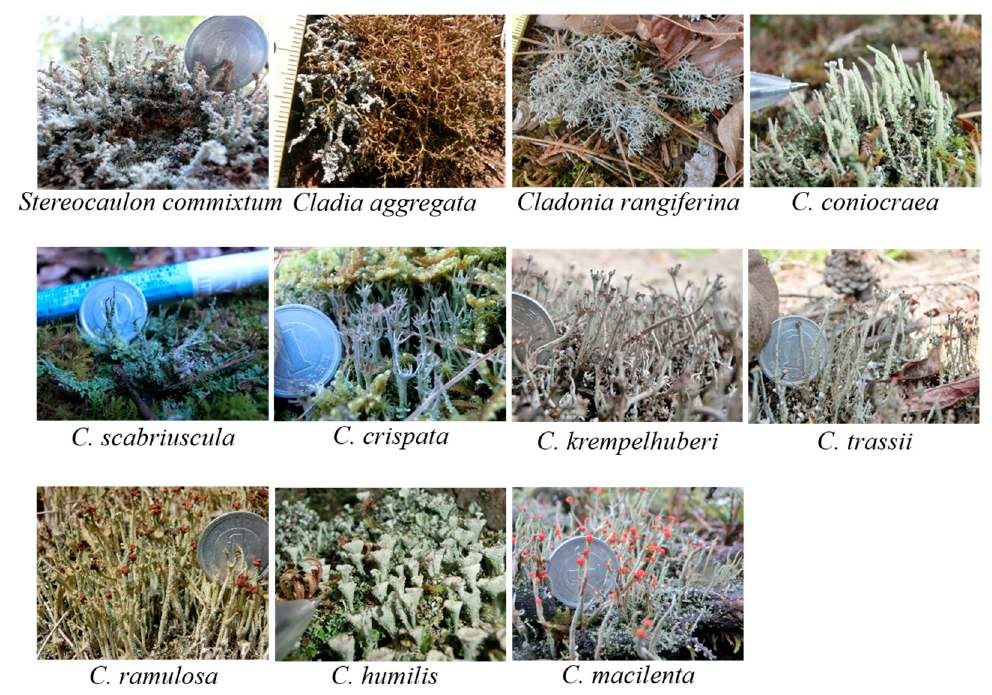
Figure 2. Several lichens growing on soil, rock, and/or mine wastes in the study